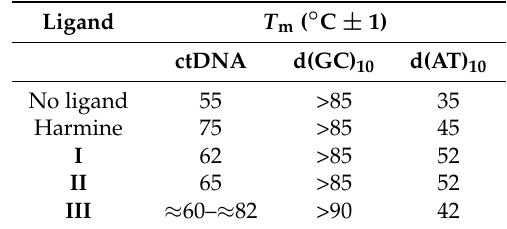
Table 1. Melting temperatures of the ctDNA, d(GC) 10 , and d(AT) 10 in the absence and presence of harmine, I , II , and III at 0.50 [ligand]:[DNA] bp ratio obtained by UV melting experiments.